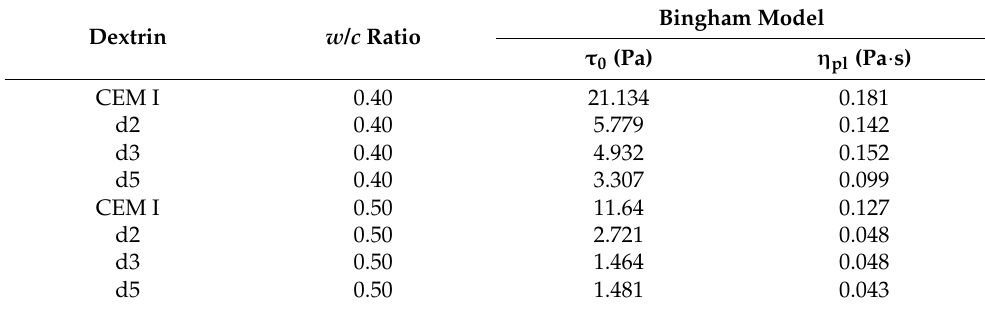
Table 4. The effect of w / c ratio and the type of starch hydrolysate on the rheological parameters of the cement